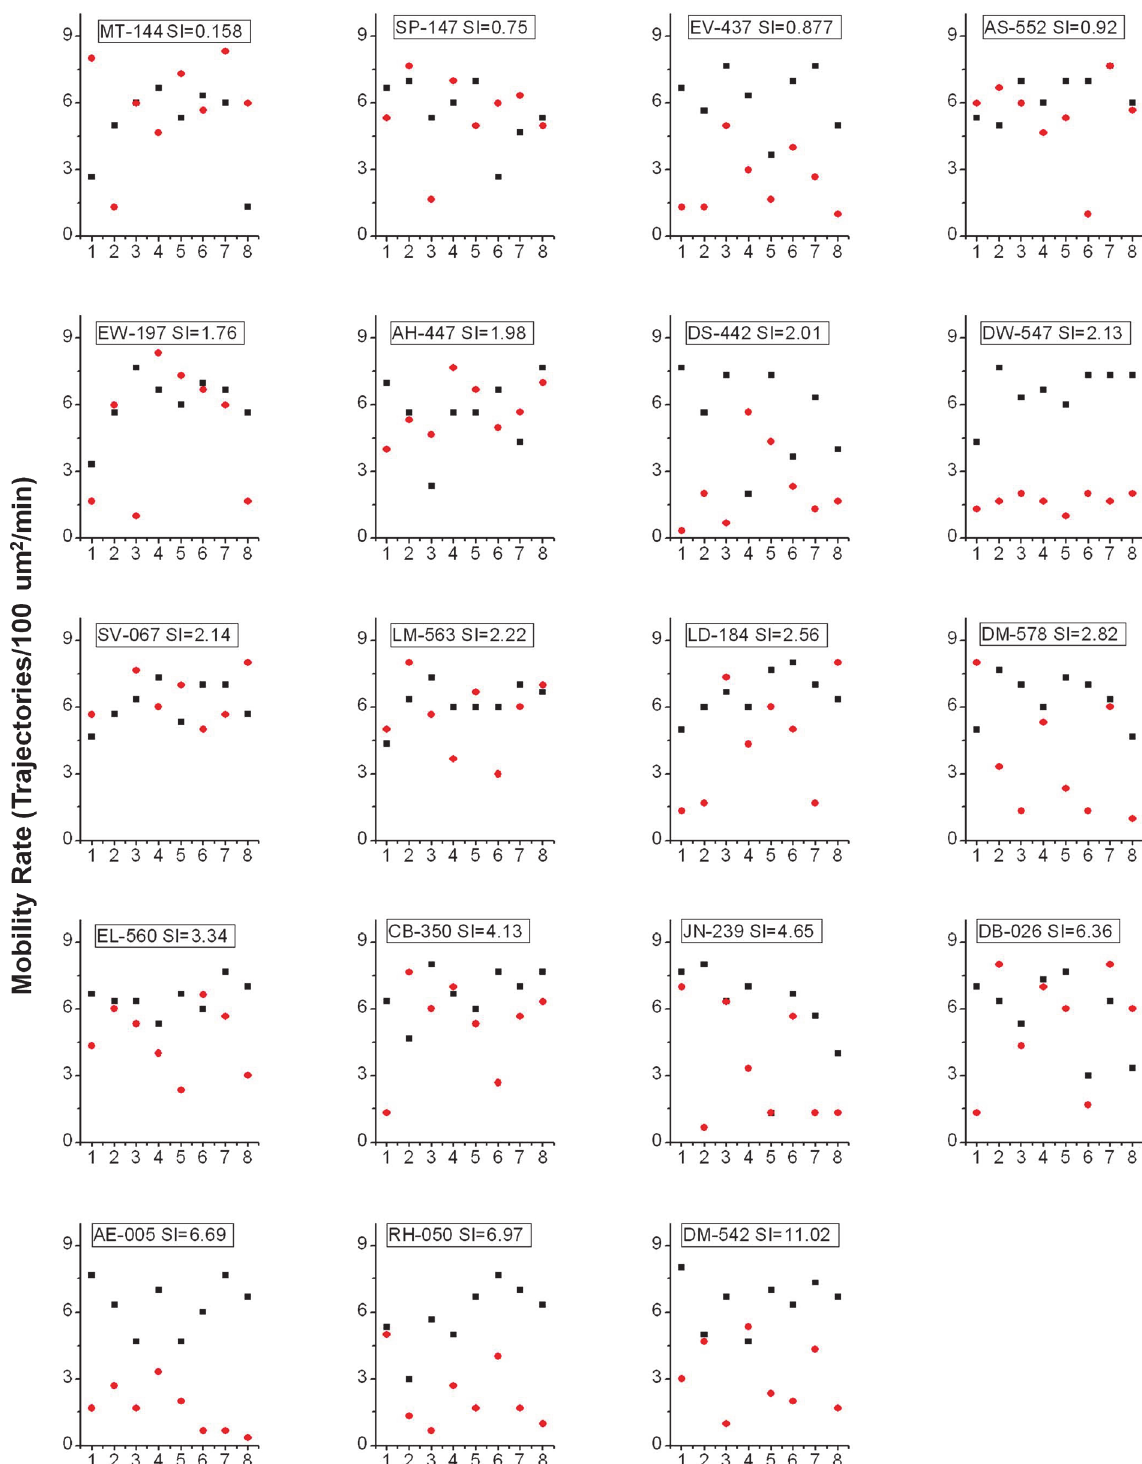
Fig 2. Mobility rate in the basal (black) and insulin-treated (red) states measured in individual cell and plotted for each subject. X axis corresponds to the sequential order in which cells were imaged for each subject. Y axis represents GSV fusion rate measured as the number mobile vesicles per 100 μ m²/min.